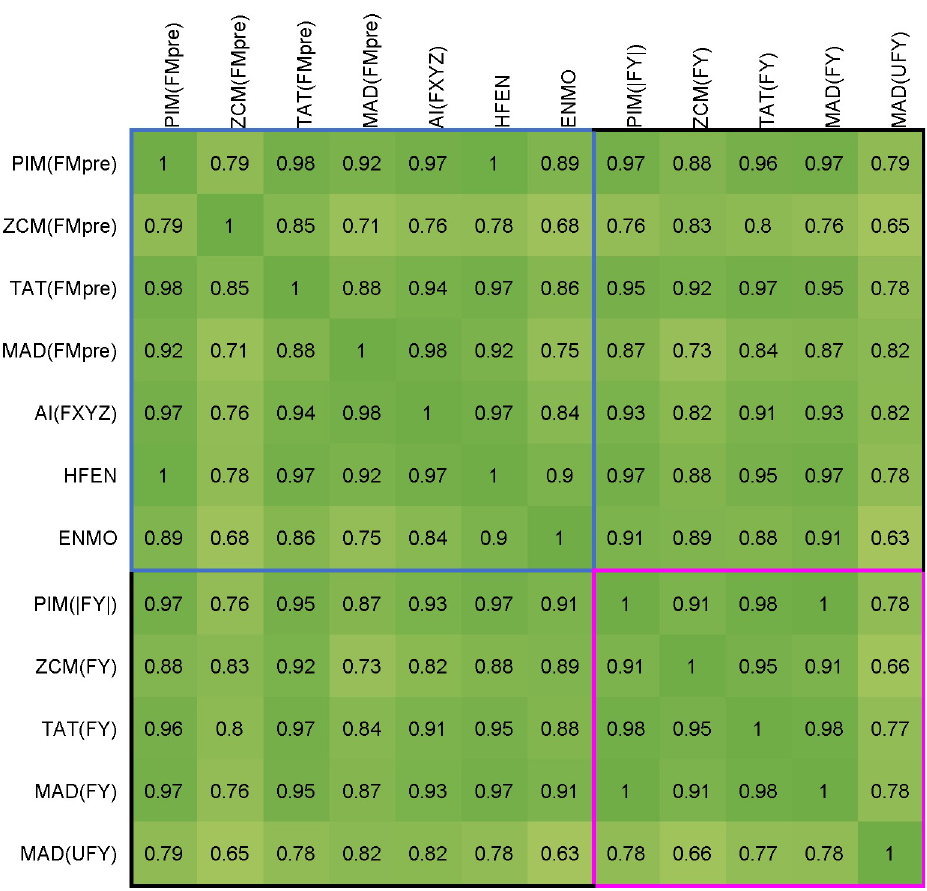
Fig 10. Correlation between activity signals calculated from filtered Y-axis accelerations (FY) and from vector magnitude of filtered axial accelerations (FMpre). MAD metric applied to UFY dataset is also included. The Pearson’s correlation coefficients are calculated by 42 measurements, and their means are represented. Cells in the blue square indicate correlations between activity signals calculated from the FMpre dataset and AI(FXYZ), ENMO and HFEN signals. Cells in the pink square include correlations between activities calculated from the y-axis datasets for those 4 metrics where we have the option to apply them to the three axes separately.